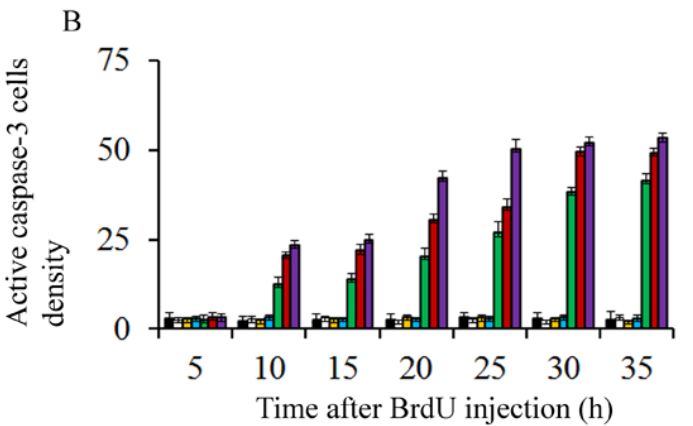
Figure 2. Mean values for TUNEL-stained ( A ) and active caspase 3-reactive neuroblasts ( B ) in the cerebellar neuroepithelium of rodents injected with saline (black columns), 25 µ g/g (white columns), 50 µ g/g (yellow columns), 75 µ g/g (blue columns), 100 µ g/g (green columns), 200 µ g/g (red columns), and 300 µ g/g of BrdU (purple columns).